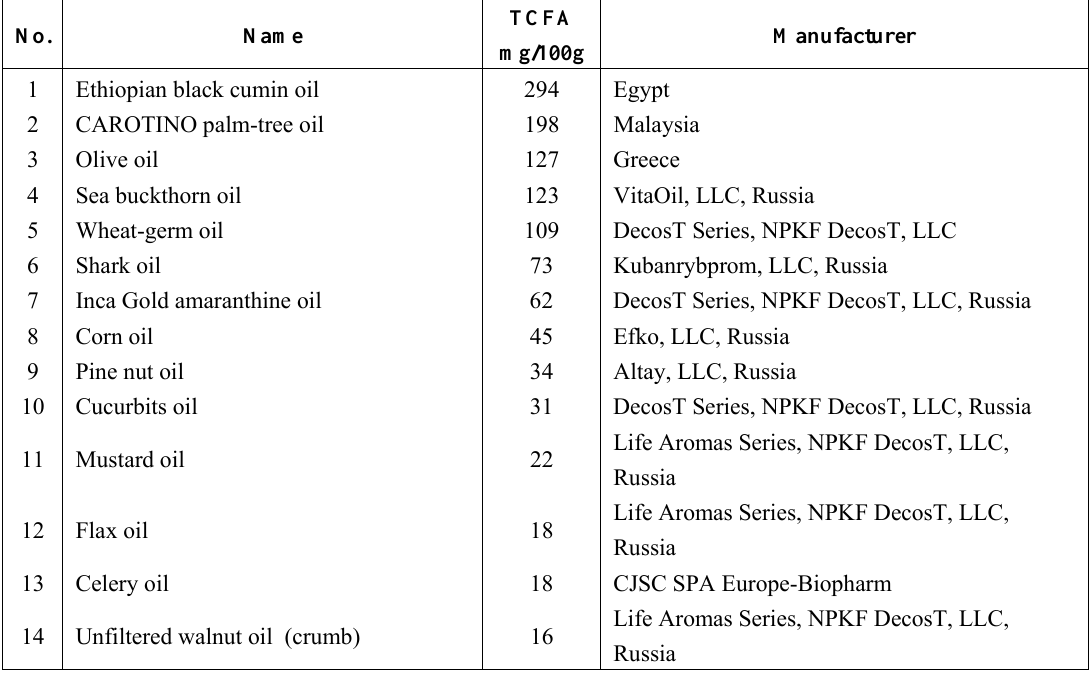
Table 5. Total Content of Fat-Soluble Antioxidants (TCFA) in Vegetable Oils (standard - gallic acid).